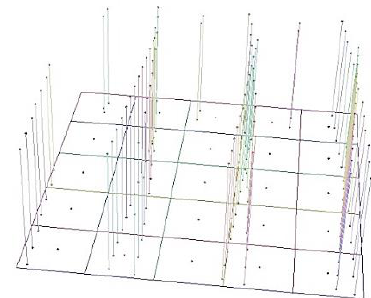
Figure 5. Dividing the machining area and establishing the center points.